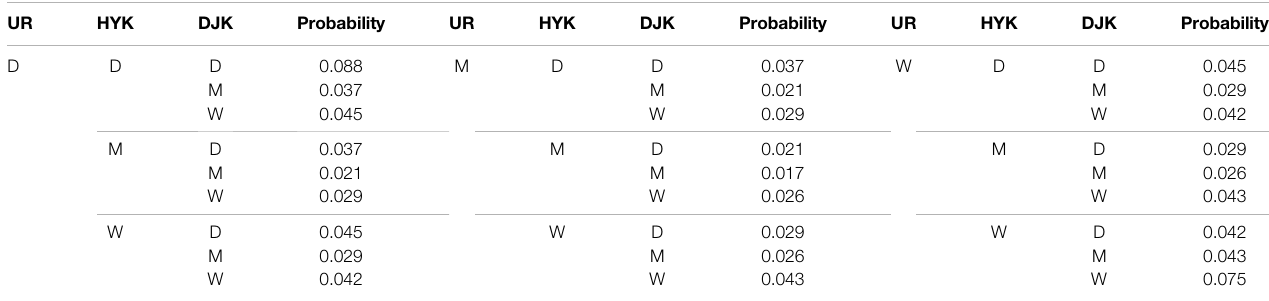
TABLE 7 | Encounter probability of trivariate combination